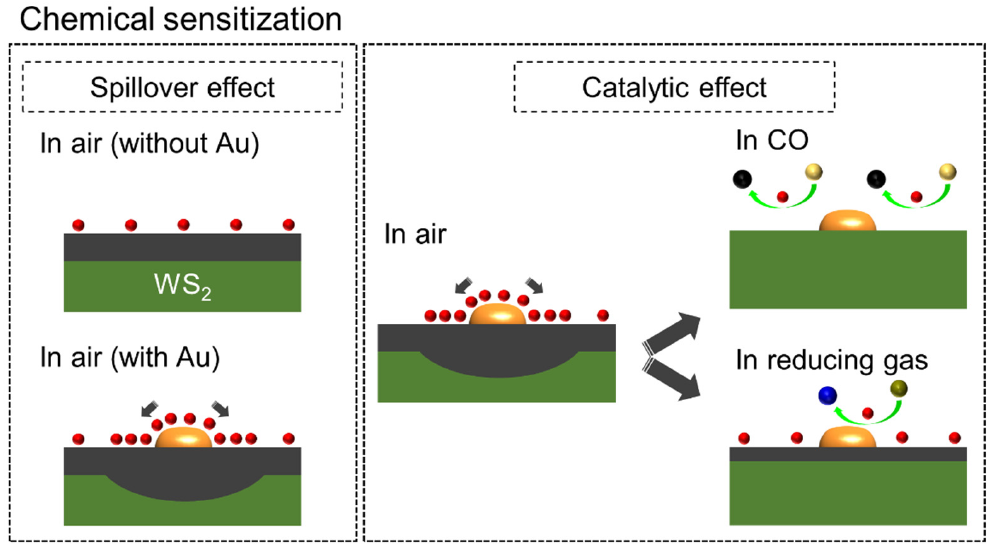
Figure 10. Gas sensing mechanism in chemical sensitization effects due to decorate the Au NPs.